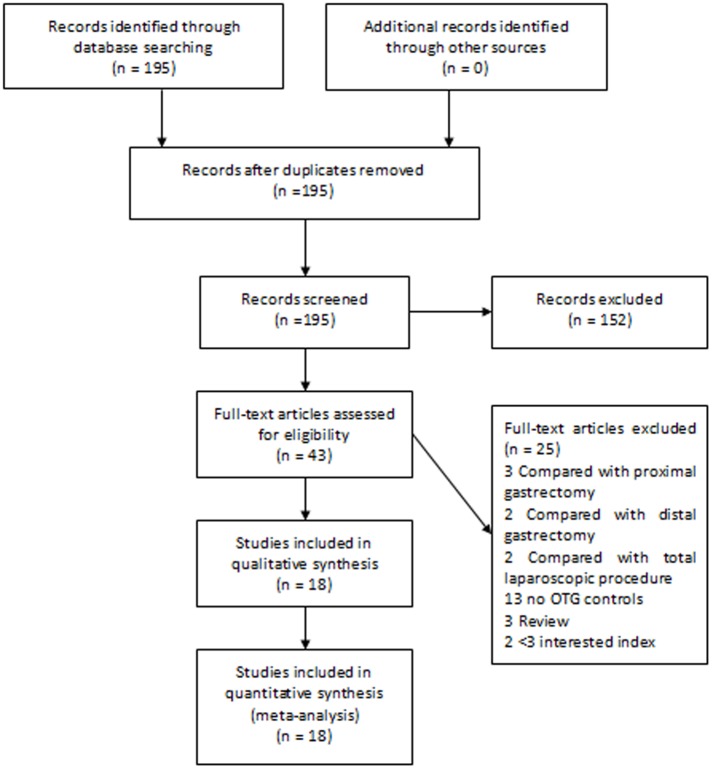
Articles identified with criteria for inclusion and exclusion.